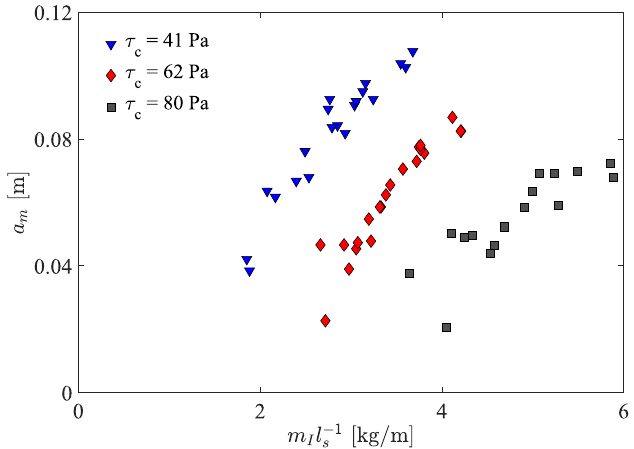
Figure 8. Variations in wave amplitude a m against m I l − 1 s , with the water depth h 0 = 0.2 m and slope angle θ = 45 ◦